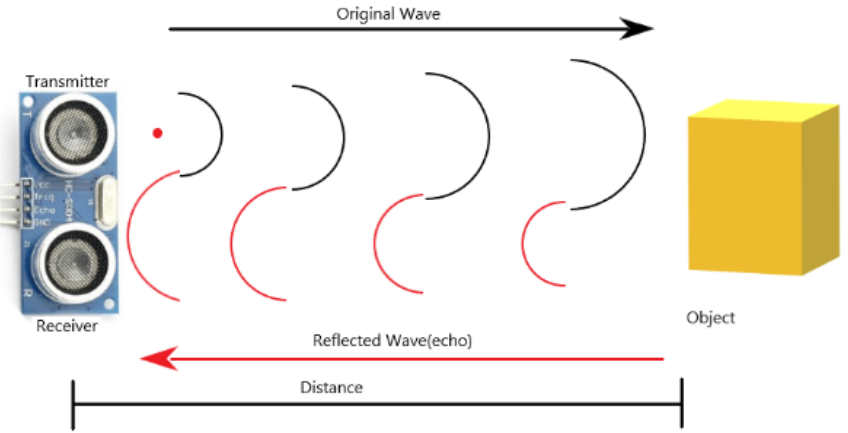
Figure 11. Ranging principle.